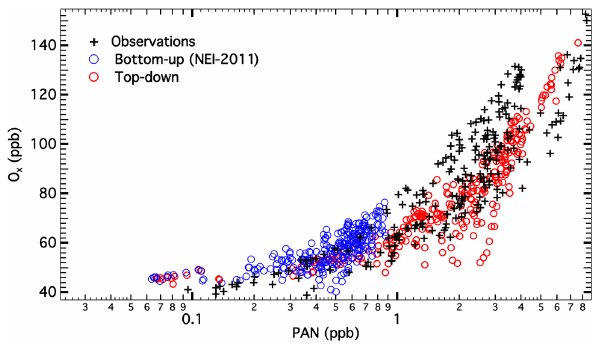
Figure 4. Scatterplot of measured and modeled hourly O x vs. PAN mixing ratios during daytime (09:00–17:00MST), 29 January–22 February 2013 at Horse